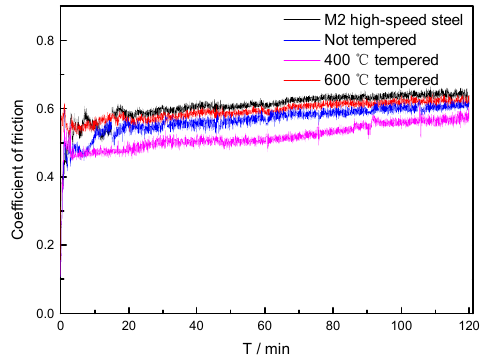
Figure 14. Coe ffi cient of friction of cladding Figure 14. Coefficient of friction of cladding layer.